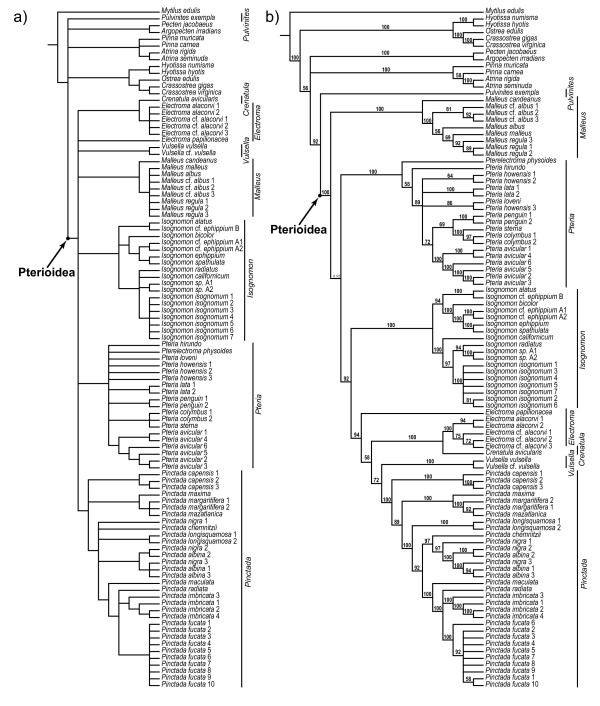
Stability trees. Strict (a) and majority-rule (b) consensus trees summarizing cladograms resulting from sensitivity analysis of the complete data set analyzed under 22 alignment parameter combinations (see text for details).